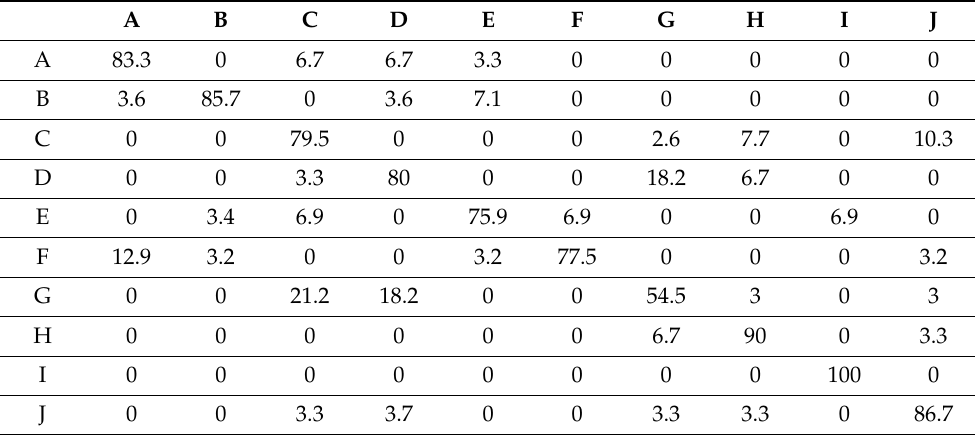
Table 4. Confusion matrix achieved by the classification model applied to all accessions of set 2 evaluated together. All values are expressed in percentage (%). Samples are indicated as follows.